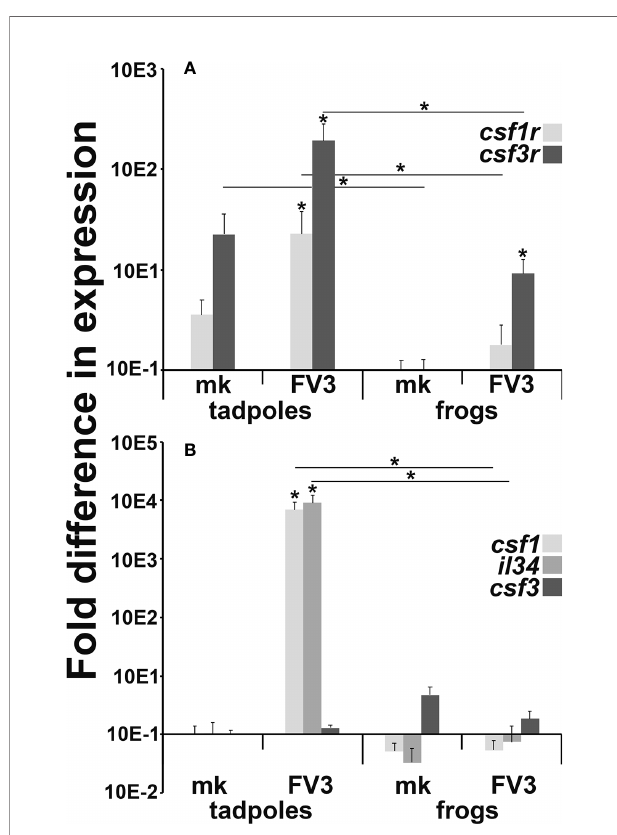
FIGURE 4 | Myeloid cell (A) growth factor receptor and (B) growth factor gene expression in FV3-challenged tadpole and adult frog intestines. Tadpoles ( N =6) and adult frogs ( N =6) were infected by water bath with 10 6 PFU of FV3 for 6 hrs and their intestinal expression of (A) csf1r , csf3r and (B) csf1 , il34 and csf3 was examined relative to gapdh endogenous control. The results are means ± SE of gene expression. Asterisks (*) denote statistical differences between mock- and FV3-infected groups and asterisks above lines (*) denote statistical differences between the treatment groups denoted by the line, p